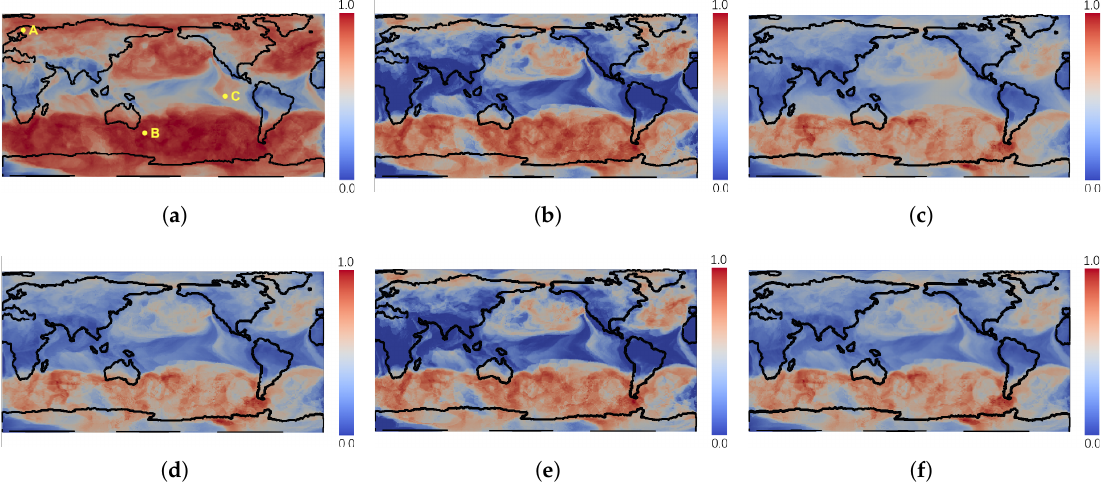
Figure 12. LU results of ECMWF data set: ( a ) result of AEDR, ( b ) result of classical EDR, ( c ) result of Euclidean distance, ( d ) result of DTW, ( e ) result of LCSS, and ( f ) result of ERP.